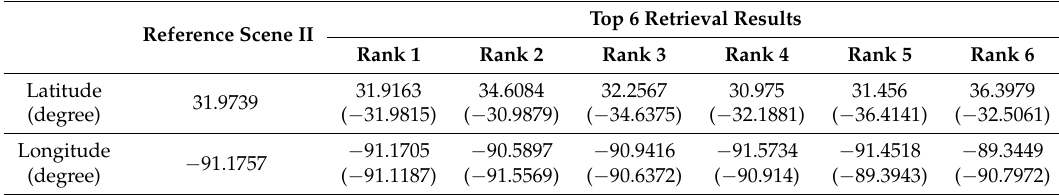
Figure 12. Top six retrieval results of reference II acquired by the use of the proposed method. Table 2. The geographic coordinates of the center pixels in the top six returned scenes with reference scene II. Coordinates included in the brackets were acquired by [28], and the others are the results of the proposed